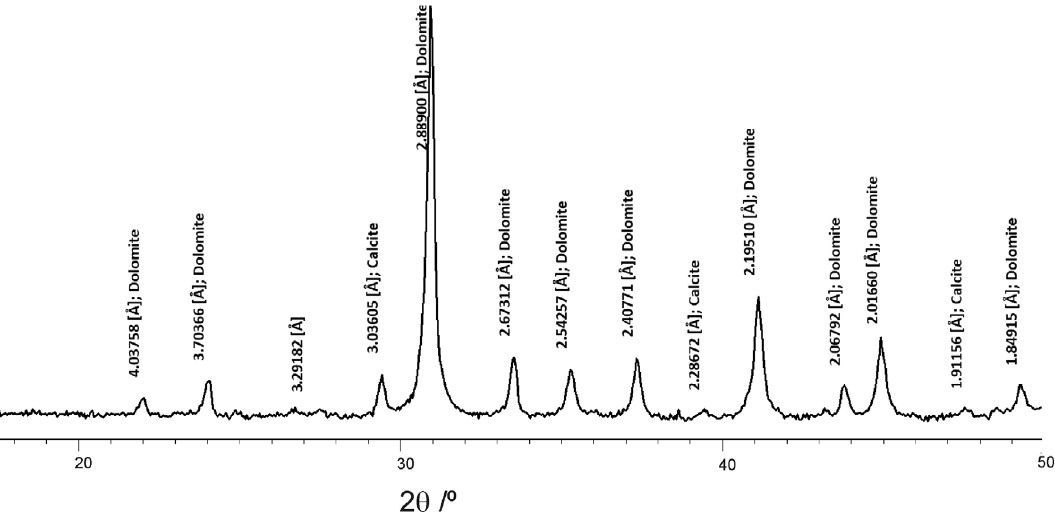
Figure 2. XRPD (X-ray powder di ff raction) pattern of the dolostones used as aggregates to make the Figure 2. XRPD (x-ray powder diffraction) pattern of the dolostones used as aggregates to make the Camarasa Camarasa concrete.